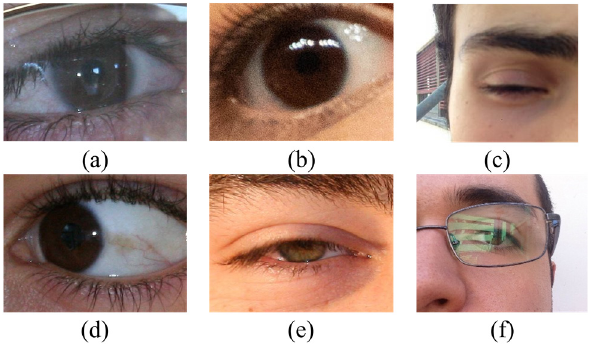
Figure 1. Iris-image preprocessing for the iris-recognition system, ⊗ presents the pixel-wise multiplication. Figure 1. Iris ‐ image preprocessing for the iris ‐ recognition system, ⊗ presents the pixel ‐ wise mul ‐ tiplication.